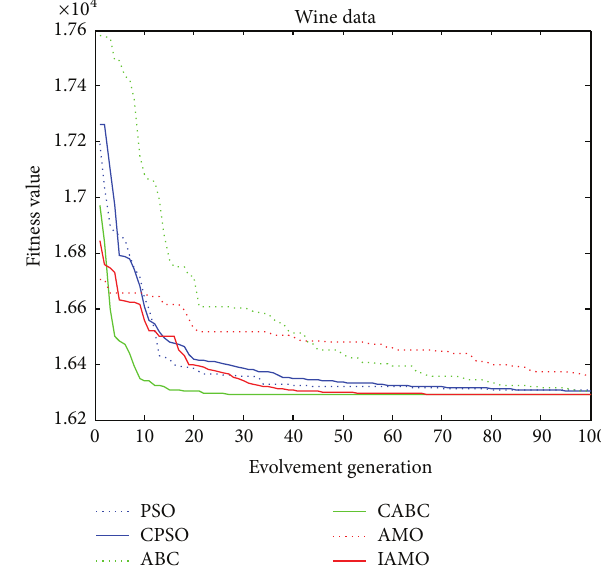
Figure 9: The convergence curve of the wine data.